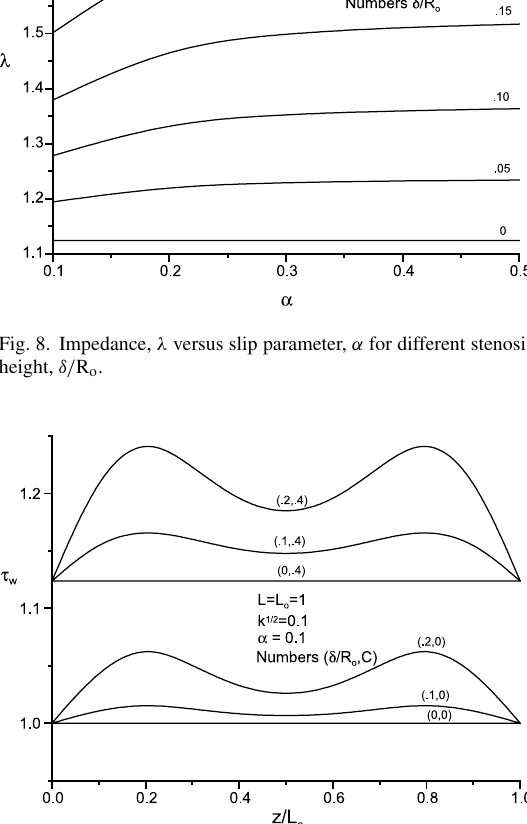
Fig. 9. Wall Shear stress distribution, τ w in stenotic region for dif- ferent δ/ R o and C.